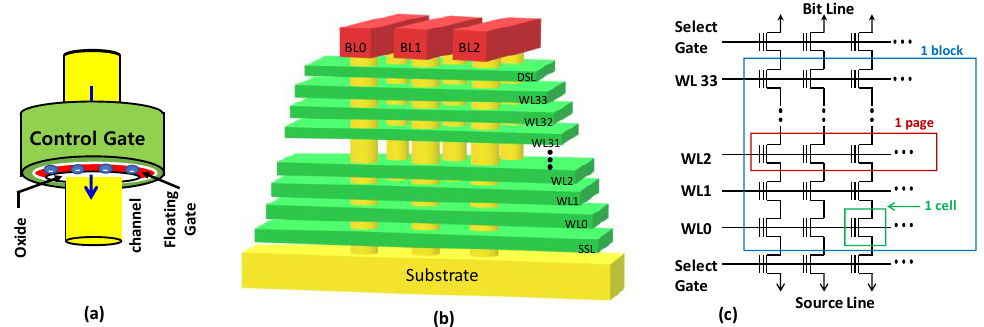
Figure 1. 3D NAND Flash Memory: ( a ) 3D flash memory cell; ( b ) physical structure of a 3D NAND flash array; ( c ) transistor-level schematic of a NAND flash memory block, which consists of 34 pages in this